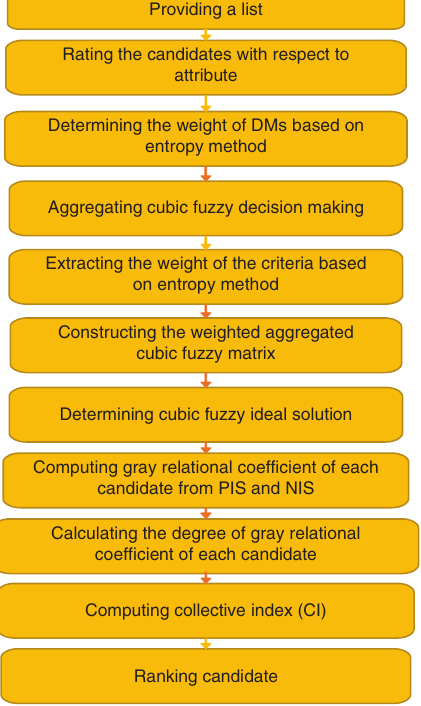
Figure 2: Flowchart of the Proposed Cubic Fuzzy